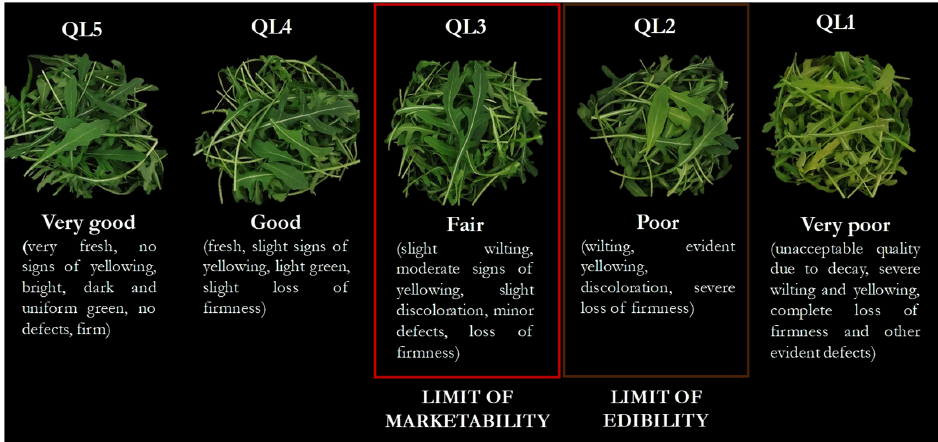
Figure 1. The figure shows the quality level (QL) scale used for the sensory evaluation of rocket